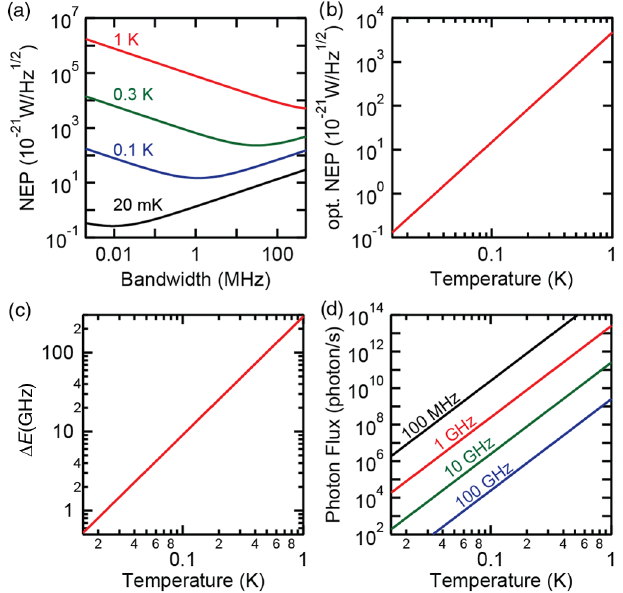
FIG. 4. (a) The expected sensitivity of graphene as a bolometer assuming n ¼ 10 9 cm 2 and A ¼ 10 (cid:2) 11 m 2 versus the coupling bandwidth, for various cryogenic operating temperatures, with (b) the optimal value of NEP versus temperature. (c) The ex- pected energy sensitivity to single photons. (d) The threshold for detection of shot noise of an incident microwave field of various